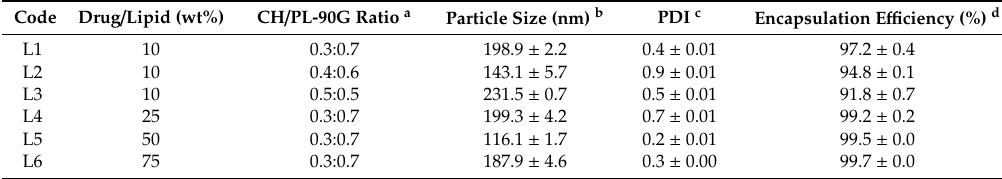
Table 1. Composition and properties of di ff erent anthralin liposomal formulations. Code Drug / Lipid (wt%) CH / PL-90G Ratio